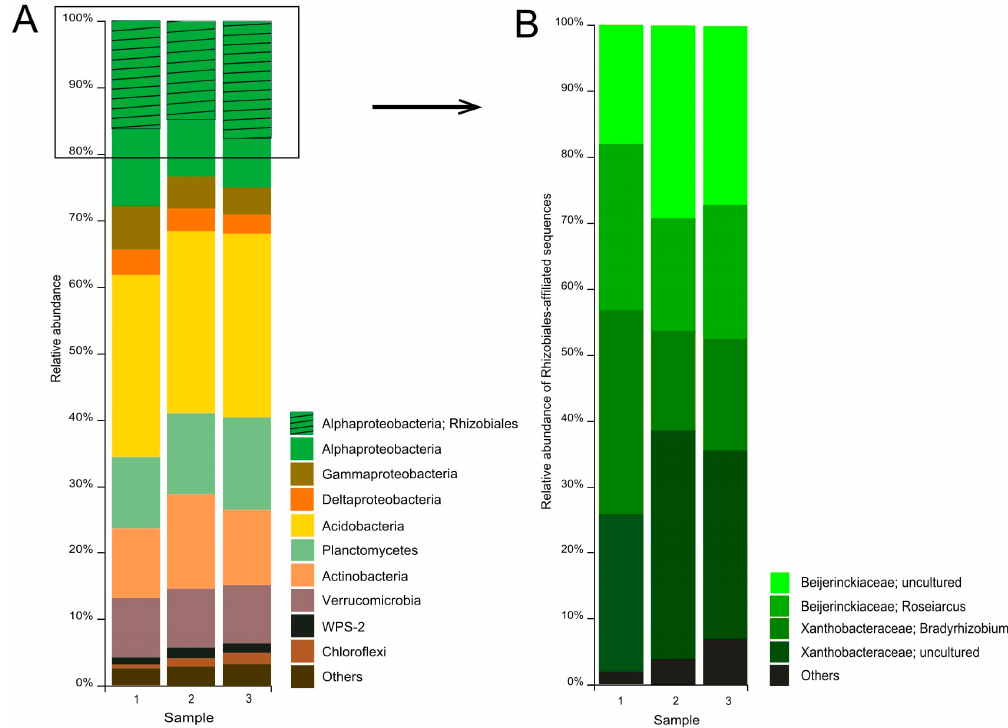
Figure 3. Bacteria community composition in forested tundra soil according to the results of Illumina-based sequencing of 16S rRNA genes. The composition is displayed at the ( A ) phylum level and ( B ) family level of the alphaproteobacterial order Rhizobiales